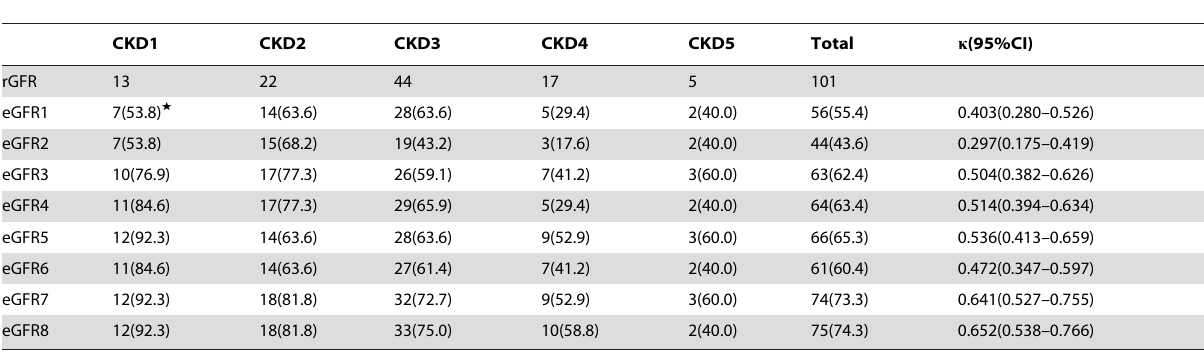
Table 5. Classification of CKD by SCr- and/or CysC-based on eGFR equations(n=101)*.